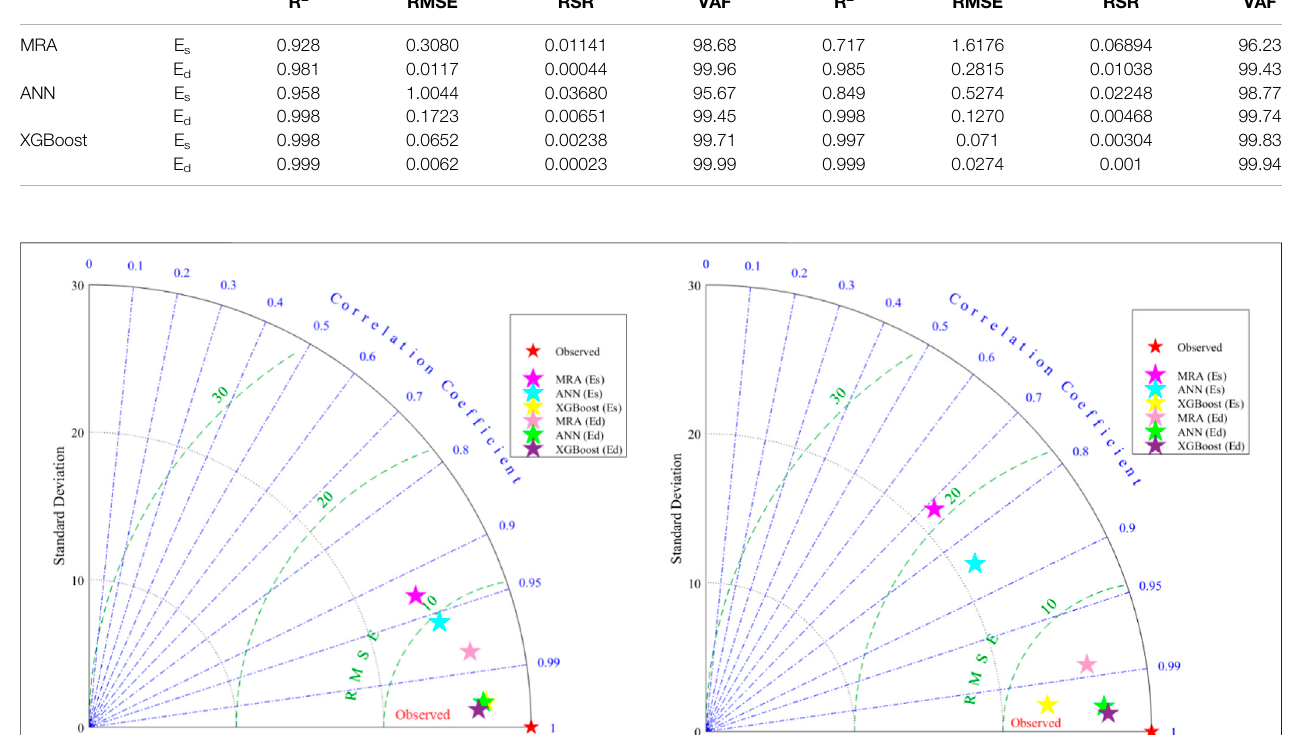
FIGURE 11 | The comparative Taylor diagrams of the proposed models MRA, ANN, and XGBoost in the (A) training stage and (B) testing stage for E s and E d .